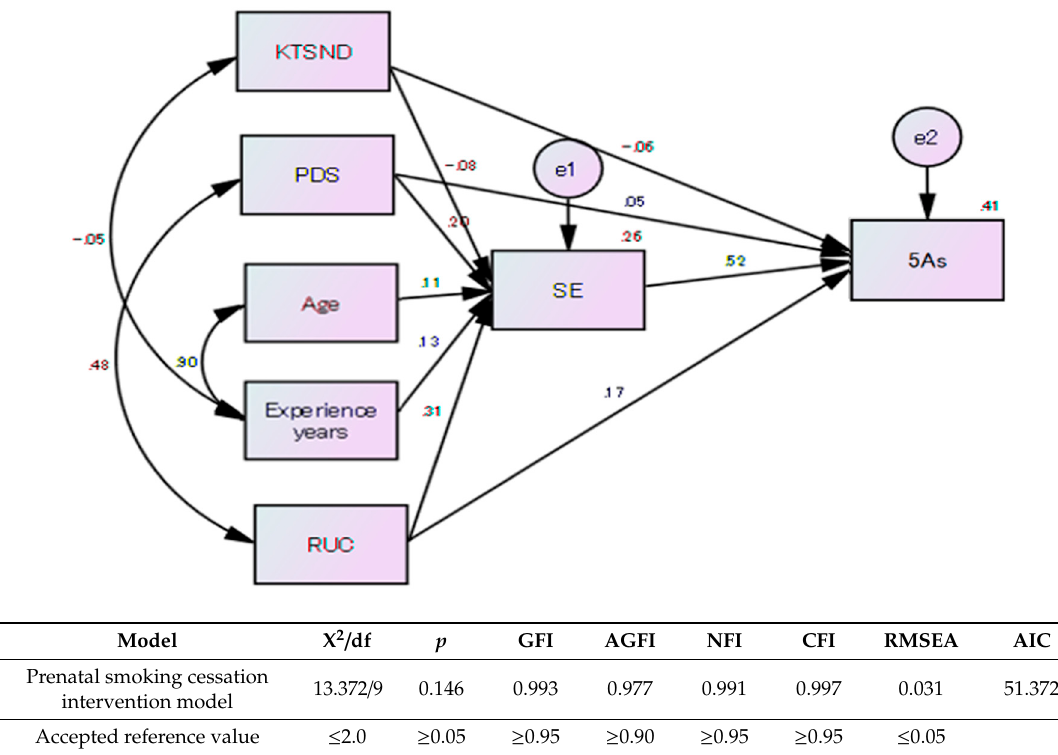
Figure 1. Prenatal smoking cessation intervention model ( n = 521).